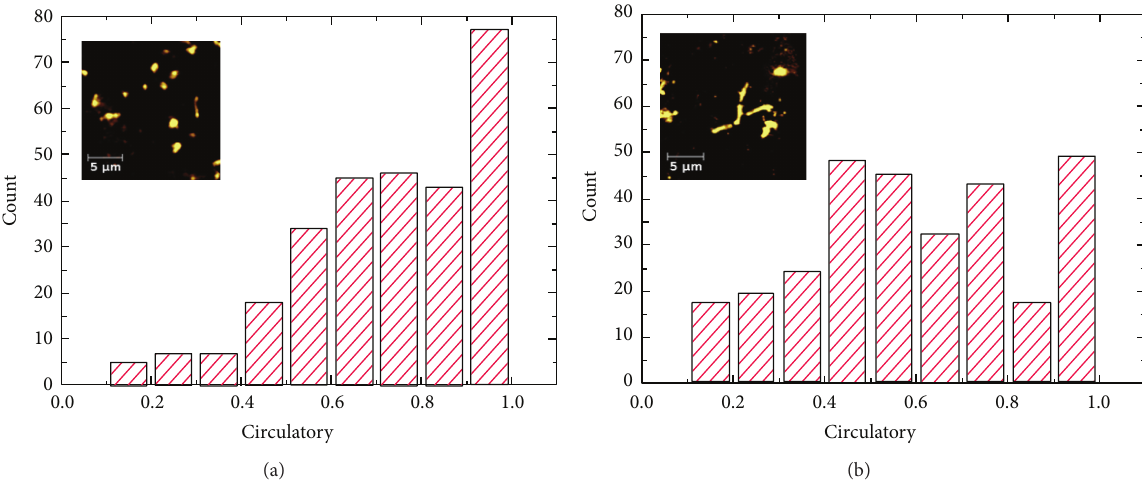
Figure 1: Quantitative (a-b) analysis of H. pylori biofilm cell morphologies in (c-d) circularity distribution is shown for each sample. The distribution was calculated by means of ten different AFM images for each sample and following the measuring system described in Section 2. Inset images show representative AFM images ( 20 × 20 𝜇 m) for each sample, which highlights the different